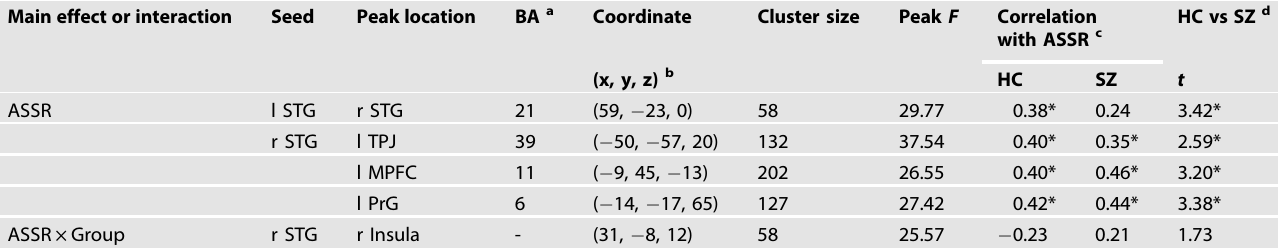
Table 2. Brain areas whose functional connectivity with left or right superior temporal gyrus were signi fi cantly related to 40 Hz auditory steady-state